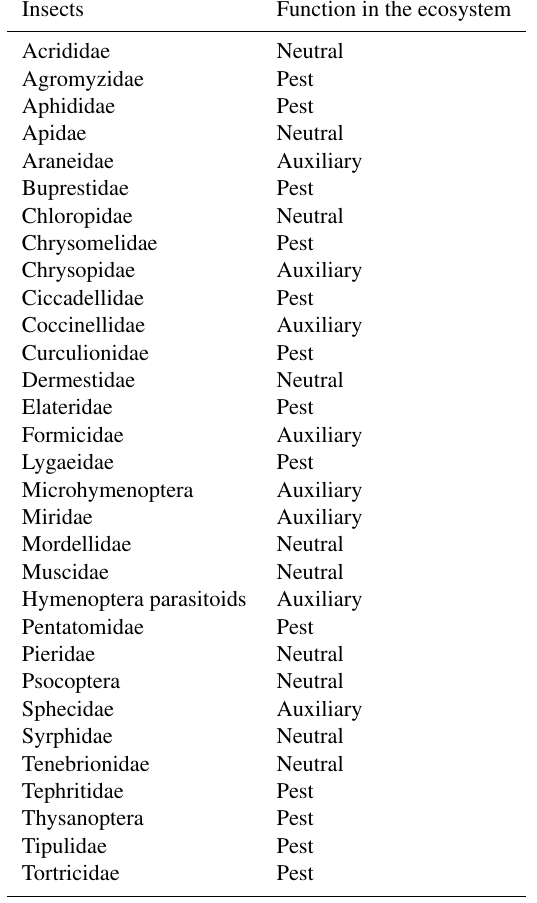
Table A2. Insect families sampled according to their function in the